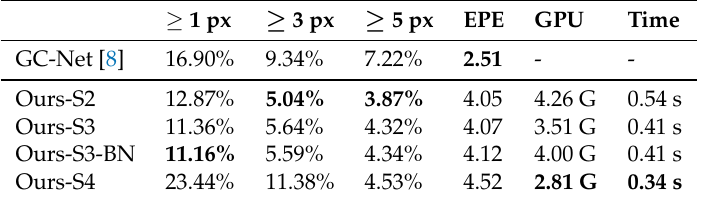
Table 3. Results on the Scene Flow dataset.